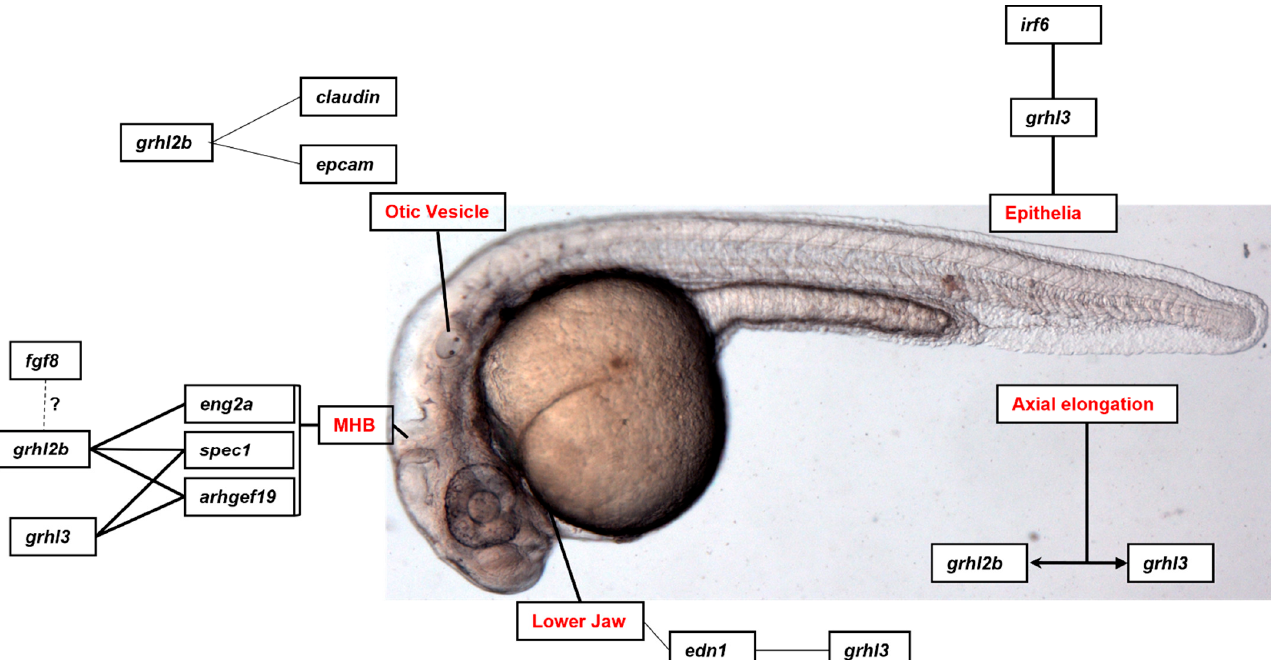
Figure 3. Grainyhead-like target genes in zebrafish development. grhl3 regulates edn1 in the development of the lower jaw in zebrafish embryos, and interacts with grhl2b in axial extension of the zebrafish tail. Irf6 governs grhl3 expression which in turn regulates keratinocyte differentiation. grhl2b regulates the development of the otic vesicles via claudin and epcam, as well as the MHB and neuroblast development and cancer via eng2a, spec1 and arhgef19. Additionally, fgf8 is a putative regulator of grhl2b regulation of the MHB.